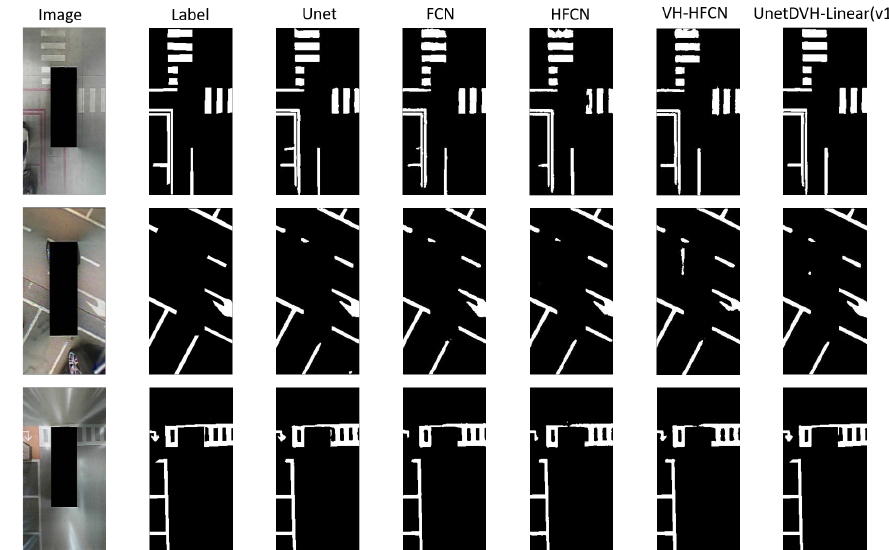
Figure 6. Example of segmentation results on the SS dataset. The first column is input images, and the second column is segmentation masks of the images. Every row represents the segmentation results for the original images of each row with different models. The third column to the sixth column is comparative experimental models. The last column is the model that performs best in our designed